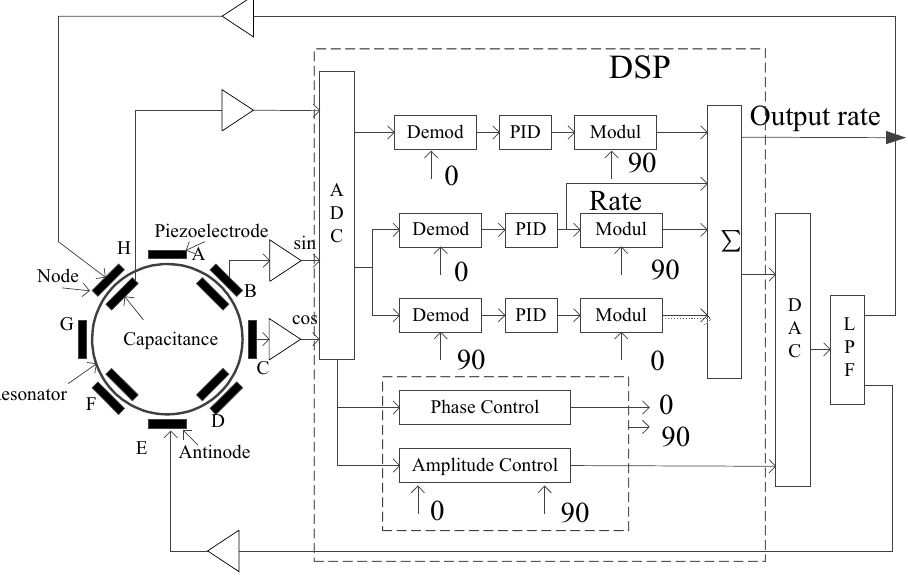
Figure 15. The block diagram of the control method and the photo of the control